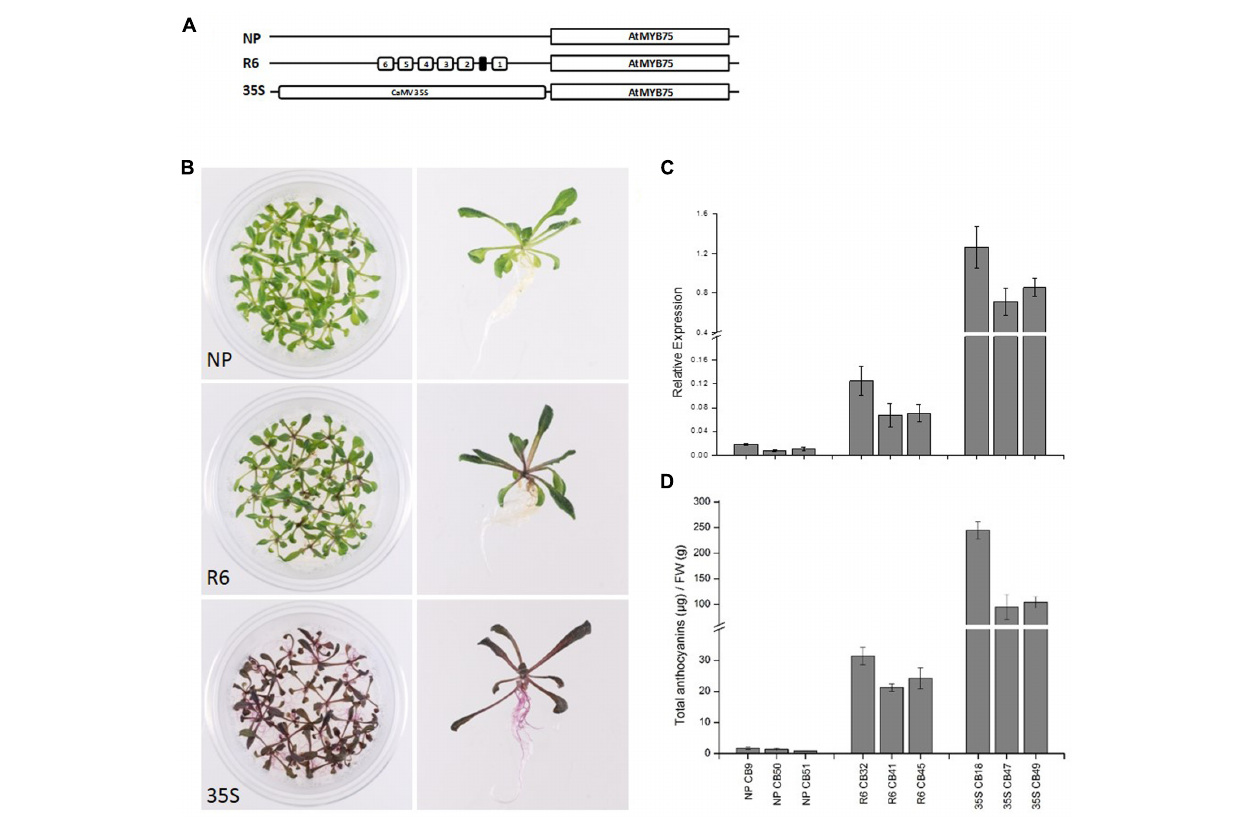
FIGURE 5 | Insertion of the R6 motif into the promoter of AtMYB75 induces AtMYB75 overexpression and ectopic anthocyanin accumulation. (A) Schematics of the engineered AtMYB75 constructs transformed into Arabidopsis. (B) Phenotype of representative T2 lines transformed by AtMYB75 pro :AtMYB75 [denoted as native promoter (NP)], AtMYB75-R6 pro :AtMYB75 (denoted as R6) and 35S pro :AtMYB75 (denoted as 35S). (C) Expression analysis by qPCR of the transcripts of the AtMYB75 gene in each transformed lines. Expression is given relative to actin and error bars represent the standard errors of the means calculated from four technical replicates. (D) Total anthocyanin content in each lines measured by HPLC and expressed as µ g of Cy-glu equivalent per gram of fresh weight